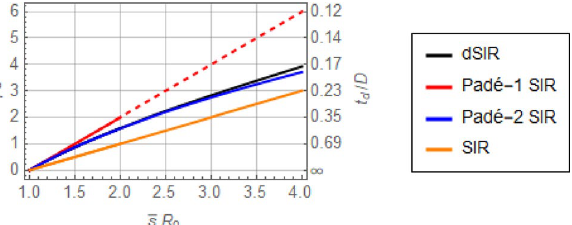
Figure 6. Dimensionless exponential rate, p 0 , or doubling period, t d / D (with respect to dimensionless time, η γ t def t / D ) for the dSIR, Padé SIR, and SIR models, by Eqs. (17), (15), (16), and (18), respectively. The first = = three rates approach each other as sR 0 approaches 1, whereas the SIR rate remains about half of the other two. The dashed portion of the Padé-1 SIR line is included only to indicate the trend, as the corresponding model would not be used in that range. Recall that p 0